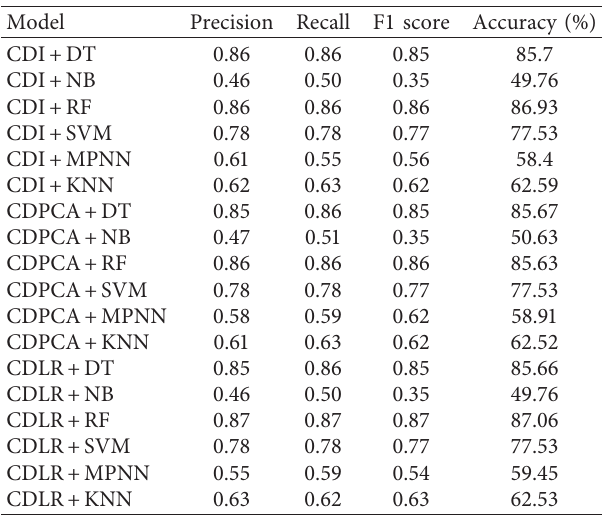
Figure 5: Experimental result of malware binary classification with cross-validation N � 10. Table 9: Results for the multiclass classification scenario without cross validation.